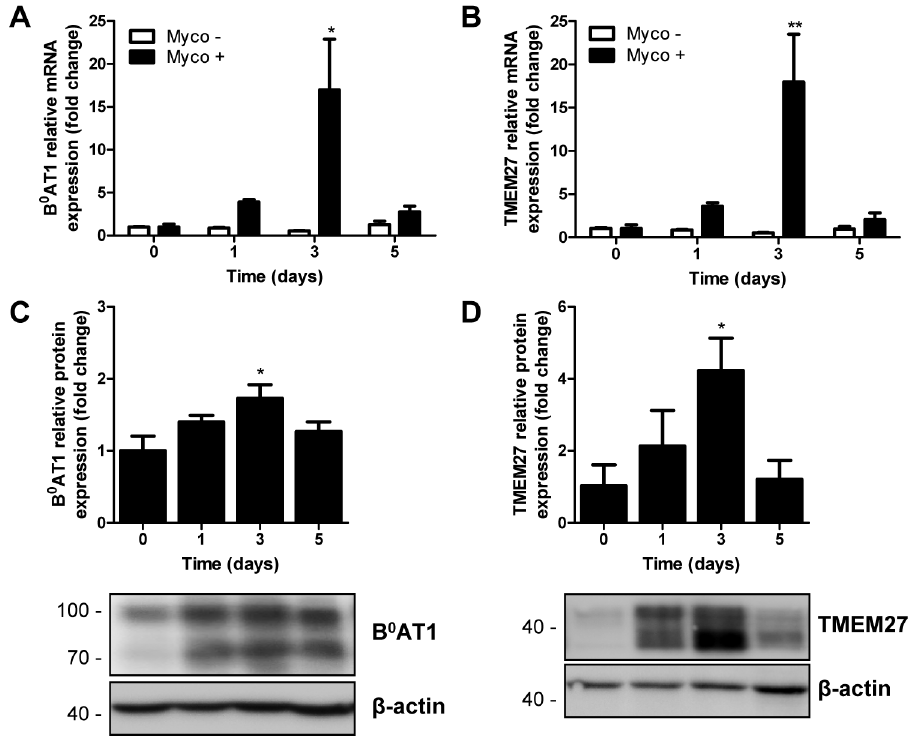
Figure 2. Effect of physiological amino acid levels on transgenes expression. Cells were cultivated on filters in standard cell culture medium and treated for the indicated times with physiological medium. A–B: mRNA expression of B 0 AT1 (A) or TMEM27 (B) was measured by quantitative PCR-analysis in B 0 AT1-TMEM27 overexpressing MDCK cells which were found mycoplasma-free (open bar) or mycoplasma-infected (black bar). mRNA levels were standardized to b -actin and normalized to time 0. C–D: Western blotting experiments with antibodies directed against B 0 AT1 (C) or TMEM27 (D) were performed in mycoplasma-infected B 0 AT1-TMEM27 overexpressing MDCK cells and the intensity of the immunoreactive bands was quantified, standardized to b -actin and normalized to time 0. Representative Western blotting images are shown. Data are represented as mean 6 SEM (n=3). Groups were compared by one-way ANOVA followed by Dunnett post-test; ** p # 0.01, * p # 0.05.